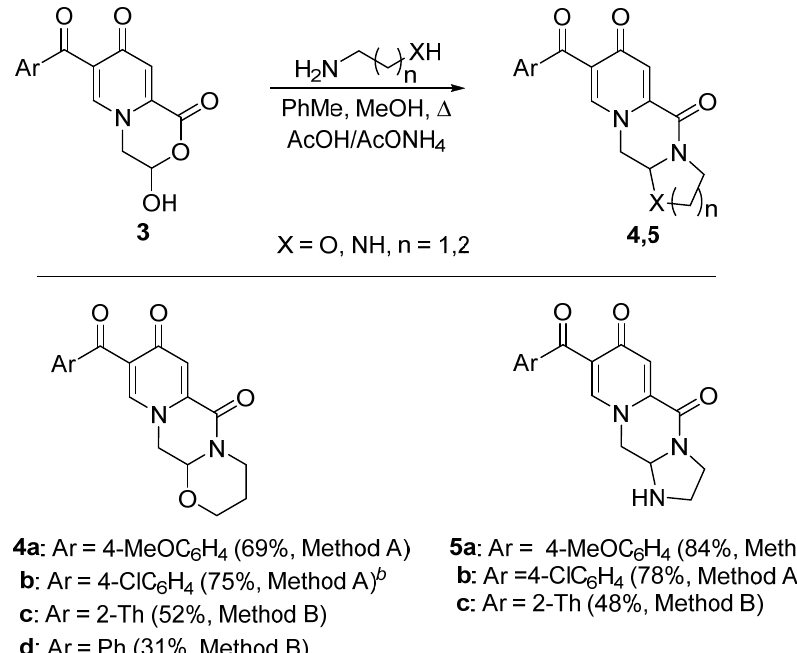
Table 3. Reactions of compounds 3 with binucleophiles a .